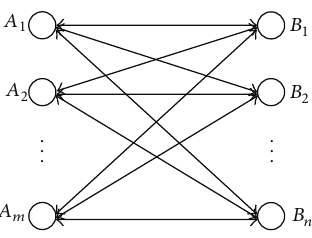
Figure 3: Transportation model.